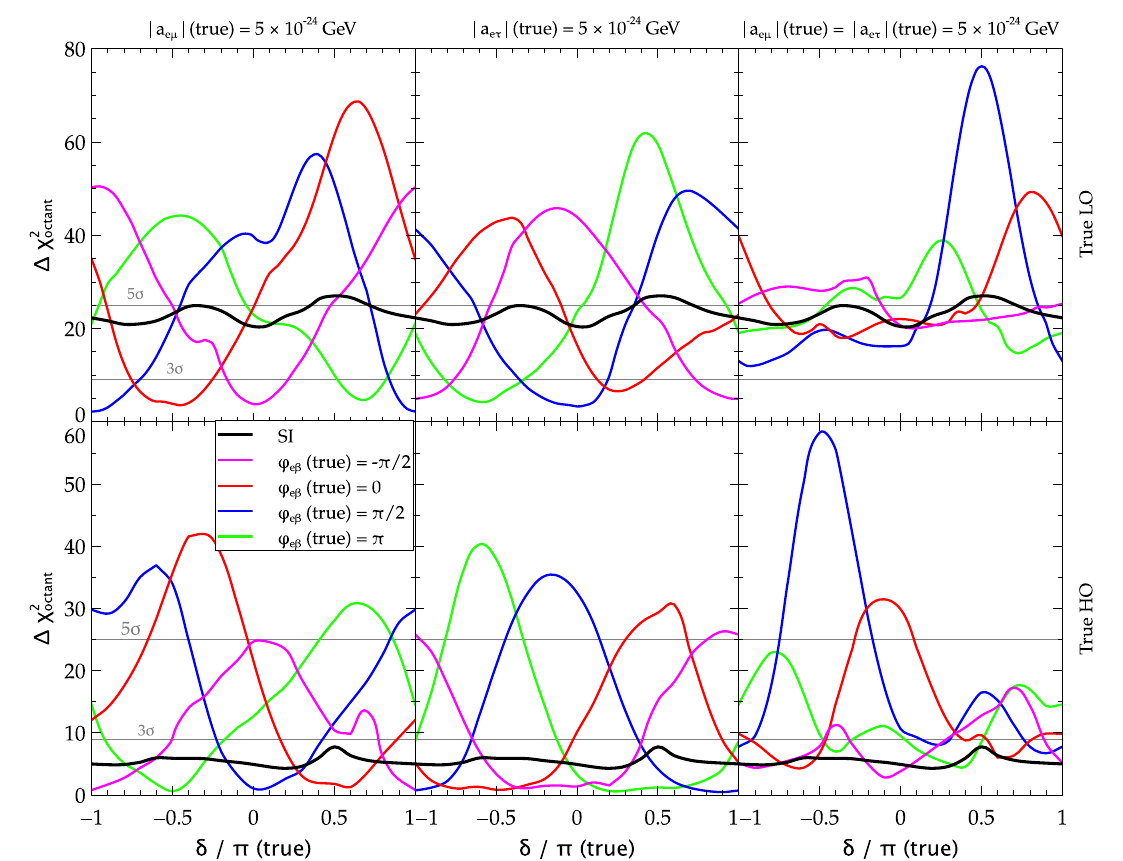
Fig. 11 Octant discovery potential as a function of true δ . In top (bot- tom) panels, we assume NO-LO (NO-HO) as the true choice with θ true = 42 . 3 ◦ (47 . 7 ◦ ) as benchmark value for LO (HO) case. In all 23 the panels, the data are generated assuming the strength of the true LIV parameter to be 5 × 10 − 24 GeV, and we do not consider the LIV param- eters in the fit (theory). The left (middle) panels are for the individual LIV parameter a e μ ( a e τ ), while the right panels deal with the case when both the LIV parameters are present simultaneously. In each panel, the